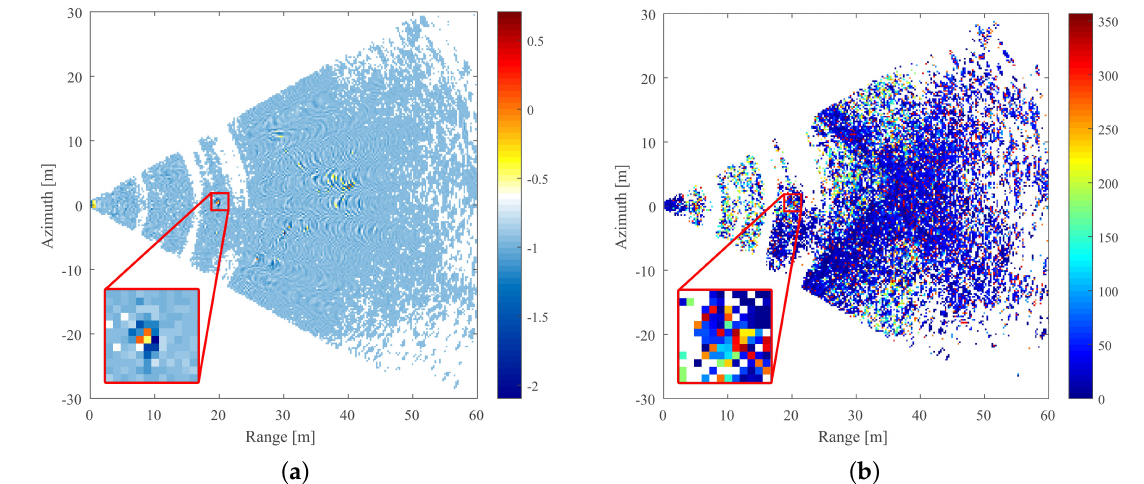
Figure 11. Phase difference spectrum. ( a ) In radians ( b ) In